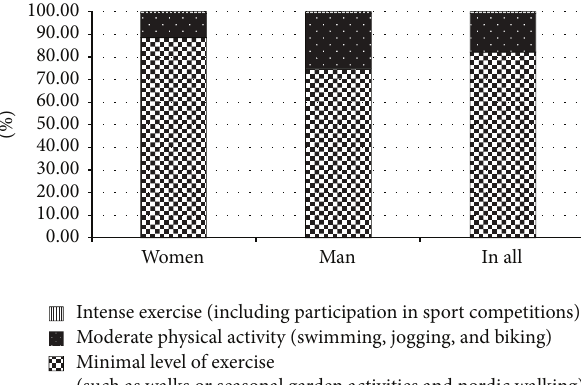
Figure 1: Products recognized as ones containing carbohydrates by study participants (an asterisk near the category name indicates a statistically significant difference by domicile; 𝑝 < 0,005).